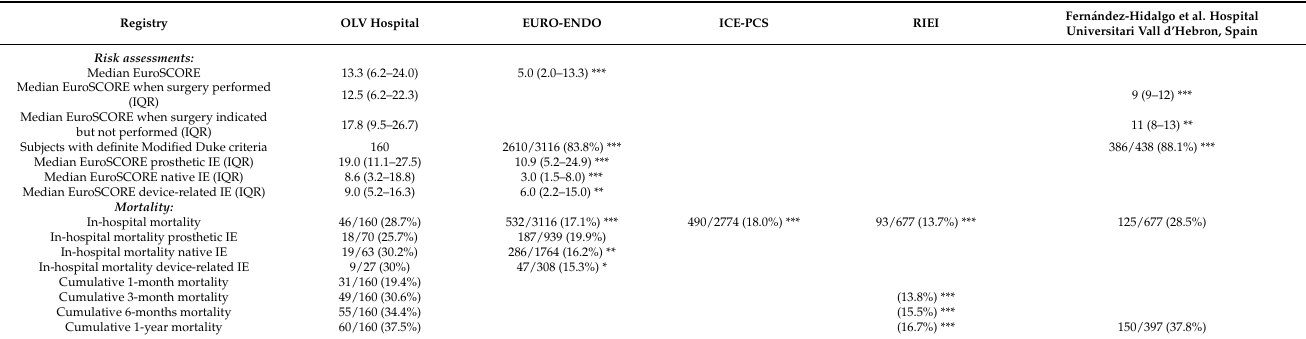
Figure 2. Survival curves of the CVCA registry. Panel 1: Patients grouped according medical or surgical treatment. Panel 2 patients grouped in one surgical and two medical treatment groups. Group I = medically treated patients conforming to the guidelines; Group II = surgically treated patients conforming to the guidelines; Group IIII = medically treated group who should have been operated, conforming to the guidelines, but were not operated (considered inoperable, refusal by the patient...). Table 3. Risk and